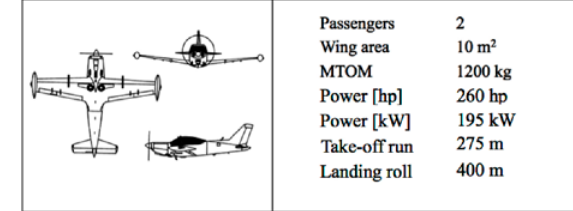
Fig. 5. Reference aircraft: 3-view sketch and technical